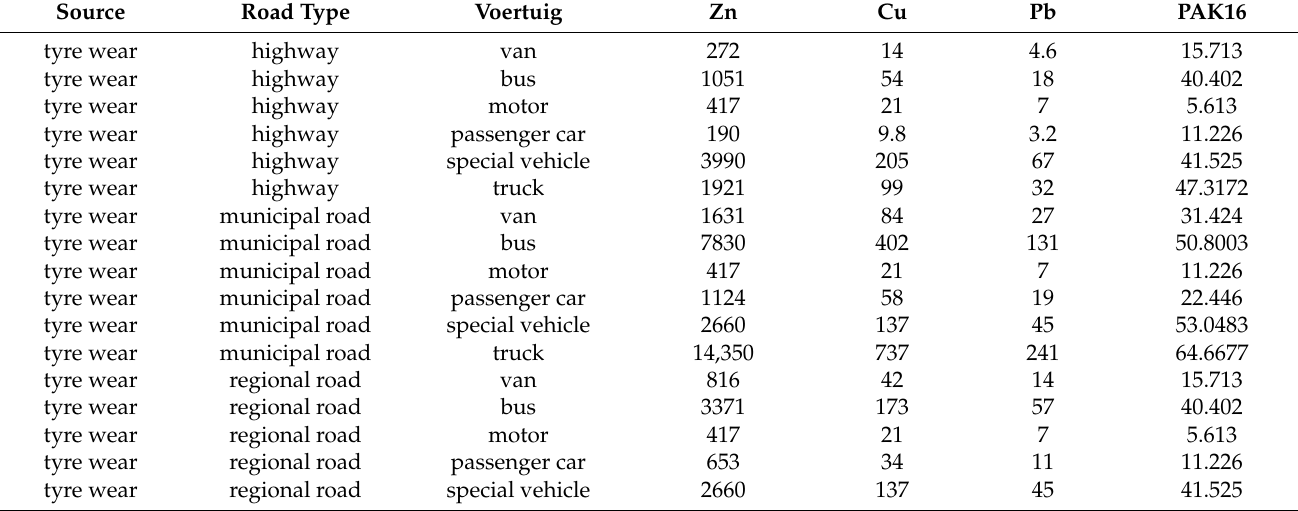
Table A3. Emission factors for vehicles (g/million vehicle km) in